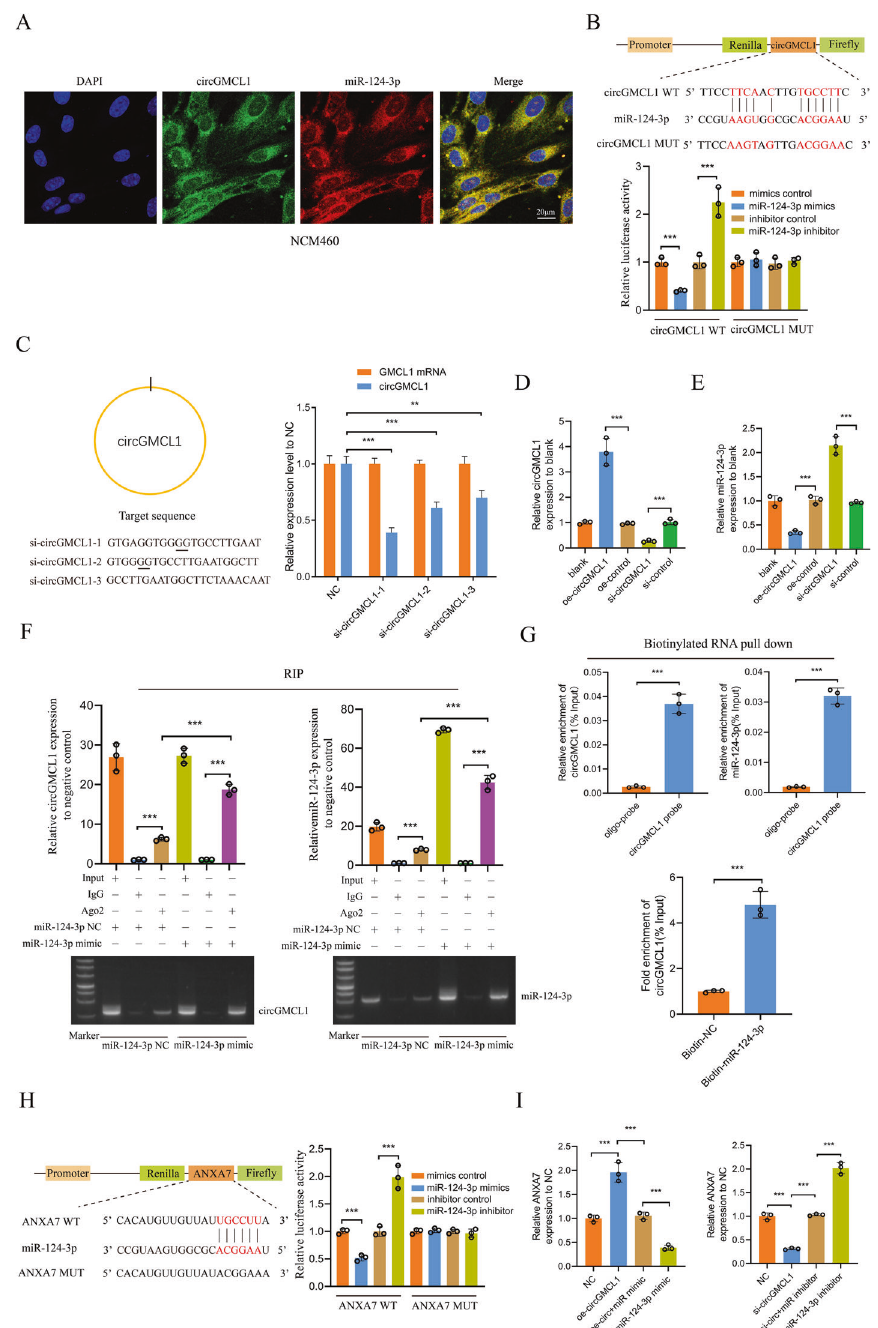
Fig. 4 Veri fi cation of the circGMCL1 ceRNA network. A FISH analyses of circGMCL1 and miR-124-3p in NCM460 cells. B Luciferase reporter analysis showing the interaction between miR-124-3p and circGMCL1 in NCM460 cells. C Relative expression of circGMCL1 and GMCL1 in NCM460 cells transfected with three siRNAs as determined by qRT-PCR tests. Relative circGMCL1 ( D ) and miR-124-3p ( E ) expression in NCM460 cells transfected with control, oe-, si-circGMCL1 by qRT-PCR. F Nucleic acid electrophoresis and qRT-PCR analyses of circGMCL1 and miR-124- 3p expression based on the Ago2 RIP assay. G Enrichment analysis of circGMCL1 and miR-124-3p after RNA pull down assay with circGMCL1 or miR-124-3p probe as evaluated by qRT-PCR assay. H Luciferase reporter analysis showing the interaction between miR-124-3p and ANXA7 in NCM460 cells. I Relative ANXA7 expression in NCM460 cells transfected with oe-, si-circGMCL1, miR-124-3p mimic, and inhibitor. FISH fl uorescence in situ hybridization, WT wild-type; MUT, mutant; qRT-PCR, quantitative real time-polymerase chain reaction; RIP, RNA immunoprecipitation; ANXA7, annexin 7. Data are expressed as mean ± SD. ** P < 0.01, *** P < 0.001 by Student ’ s t or one-way ANOVA